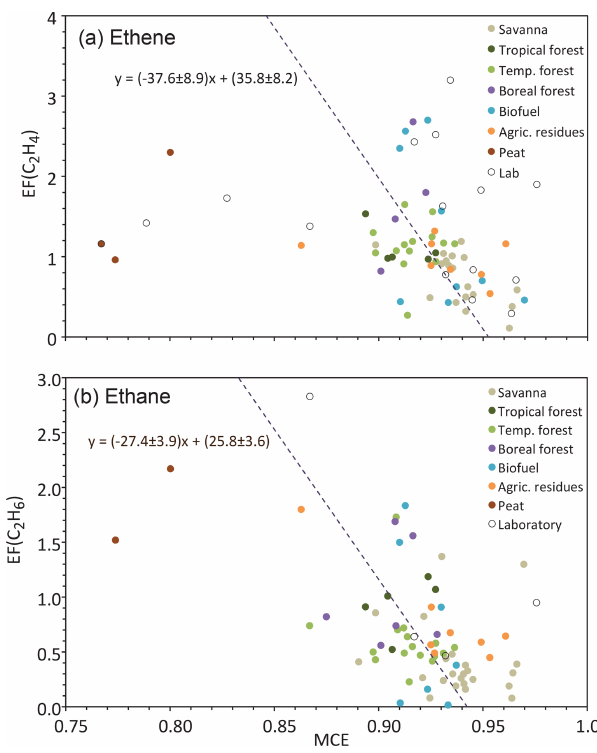
Figure 1. Scatter plots of the emission factors of ethene (a) and ethane (b) against MCE, based on studies in the different combus- tion